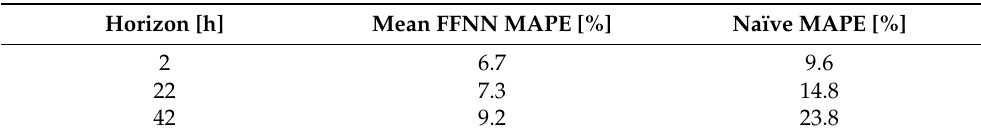
Table 1. Performance of initial FFNN models compared with a persistence (naïve) forecast with the same horizon. Horizon [h] Mean FFNN MAPE [%] Naïve MAPE